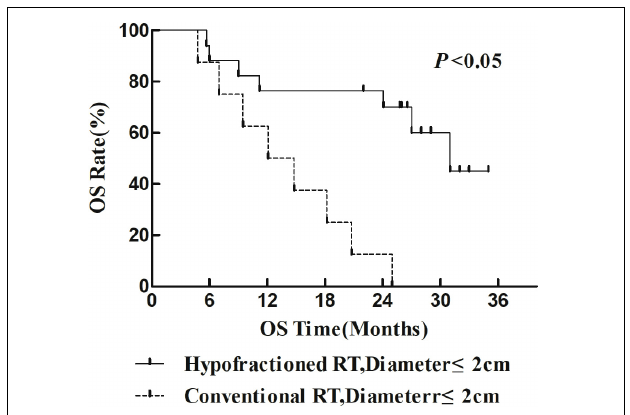
FIGURE 4 | Comparison of OS between HFR group and CFR group in patients with lymph node diameter > 2 cm.